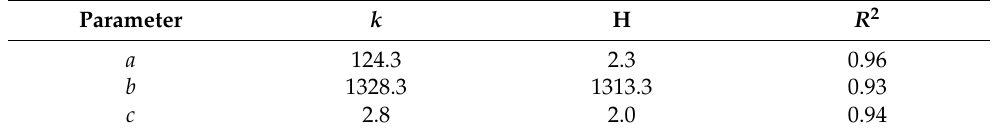
Table 6. Calculated parameter values k ,